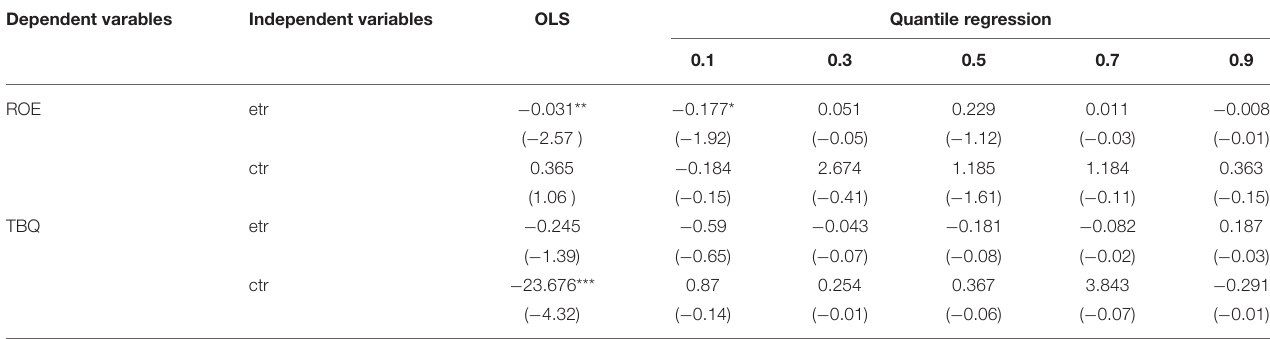
TABLE 9 | Quantile regression results. Dependent